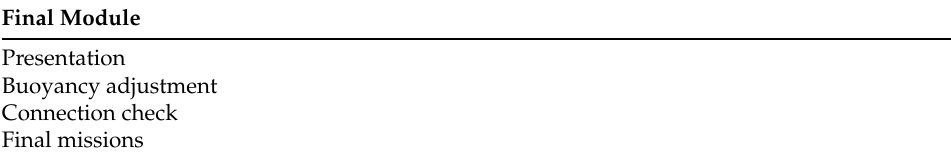
Table 3. One-day format